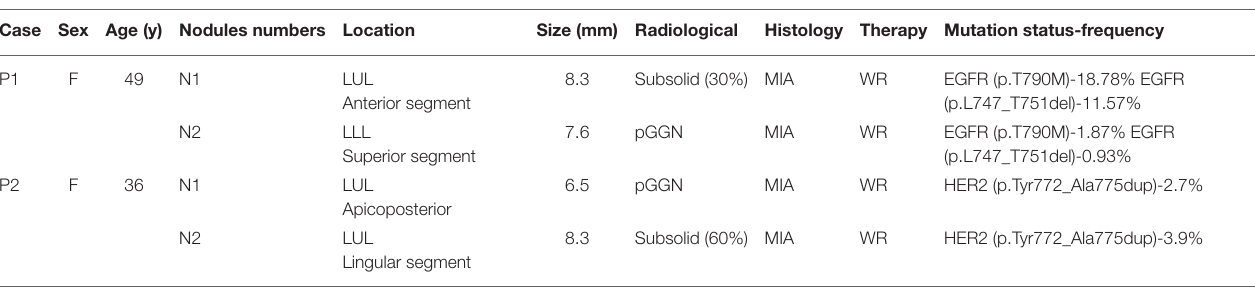
TABLE 1 | Clinicopathological characteristics and mutation status of P1 and P2. Case Sex Age (y) Nodules numbers